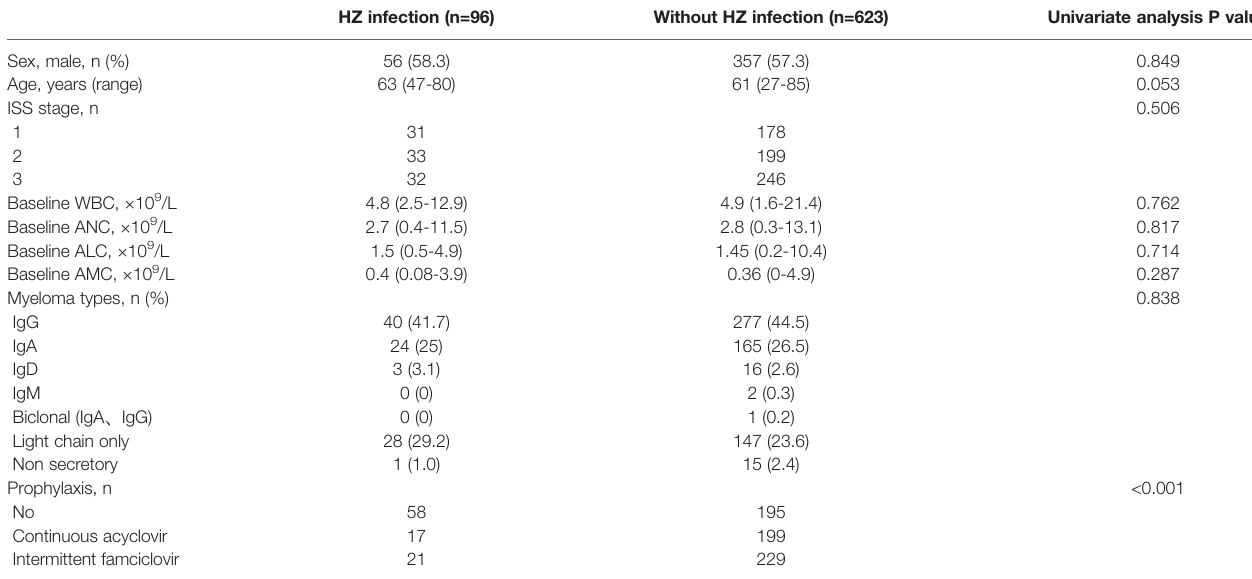
TABLE 4 | Predictive factor for HZ